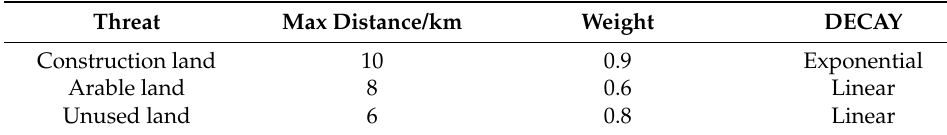
Table 4. Setting of the threat factor parameters.